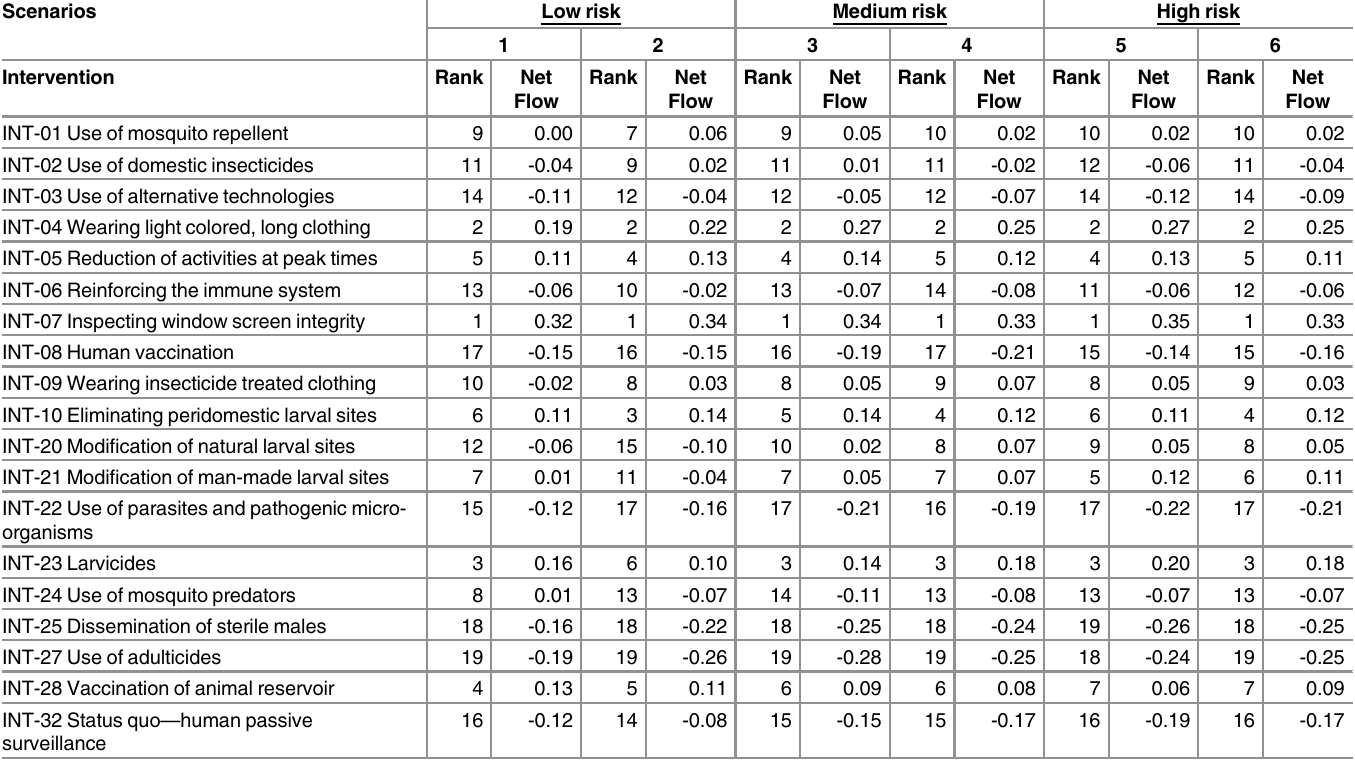
Table 8. Ranking of the individual-level protection and regional-level management interventions